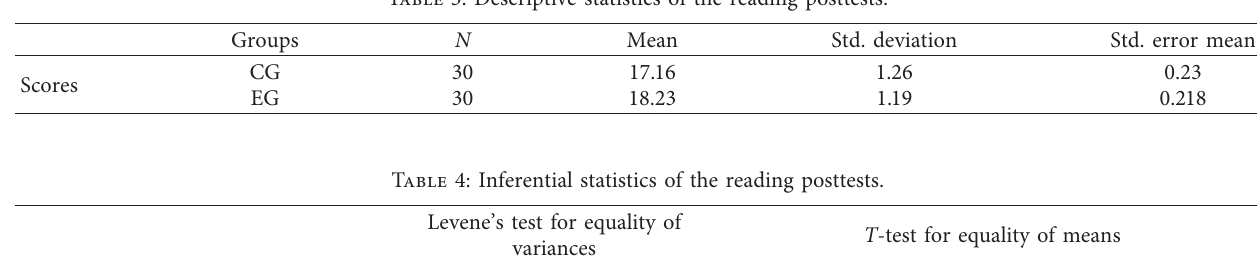
Table 3: Descriptive statistics of the reading posttests.